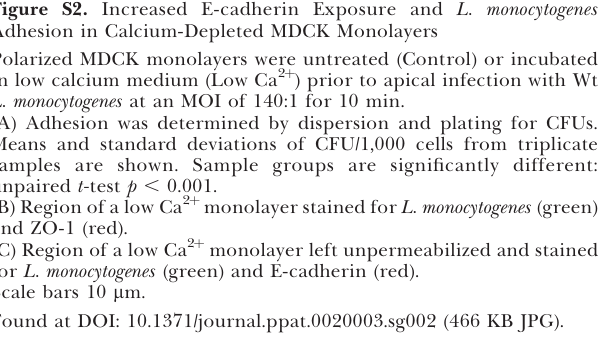
Figure S2. Increased E-cadherin Exposure and L. monocytogenes Adhesion in Calcium-Depleted MDCK Monolayers Polarized MDCK monolayers were untreated (Control) or incubated in low calcium medium (Low Ca 2 þ ) prior to apical infection with Wt L. monocytogenes at an MOI of 140:1 for 10 min. (A) Adhesion was determined by dispersion and plating for CFUs. Means and standard deviations of CFU/1,000 cells from triplicate samples are shown. Sample groups are significantly different: unpaired t- test p , 0.001. (B) Region of a low Ca 2 þ monolayer stained for L. monocytogenes (green) and ZO-1 (red). (C) Region of a low Ca 2 þ monolayer left unpermeabilized and stained for L. monocytogenes (green) and E-cadherin (red). Scale bars 10 l m. Found at DOI: 10.1371/journal.ppat.0020003.sg002 (466 KB JPG). Figure S3. Lack of Association of L. monocytogenes Invasion with the Intestinal Crypts or the Peyer’s Patches; inlA -mutant Is Noninvasive (A) A rabbit ileal loop was infected with 4 3 10 7 CFU/ml of Wt L. monocytogenes expressing GFP (Wt-GFP) for 4 h. Optical